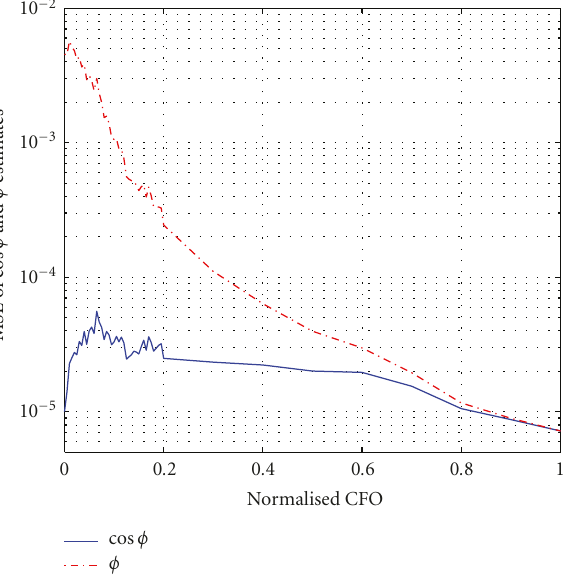
Figure 2: Mean square error of the estimates for cos φ and φ versus normalized CFO, where SNR = 22